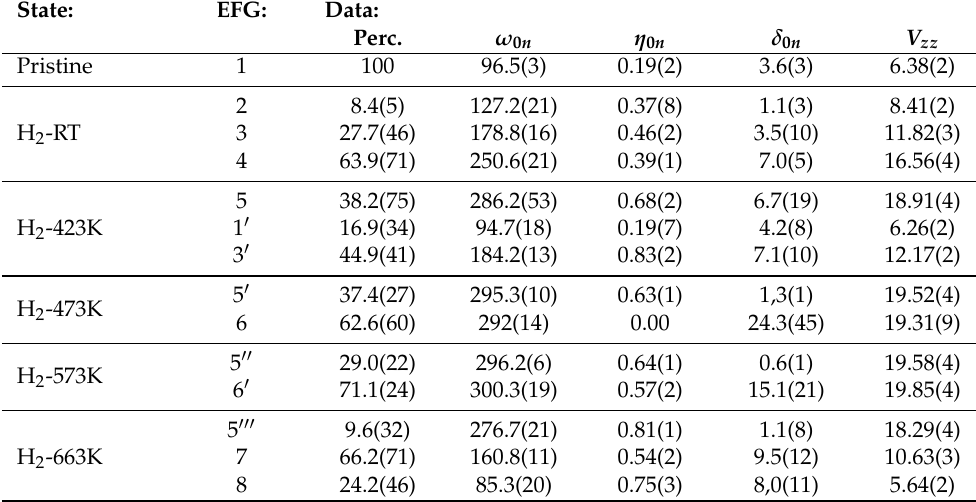
Table 1. 111 m Cd/Cd fitting parameters featuring the main EFGs fractions. ω 0 is given in Mrad · s − 1 , δ (which is a relative width of a distribution) and perc. are in %, while V zz numbers are presented in (10 21 V · m − 2 ). EFG of the same origin are marked with colours. Spectra H 2 -RT, H 2 -423K and H 2 -663K are fitted in one of the possible ways due to the complex local